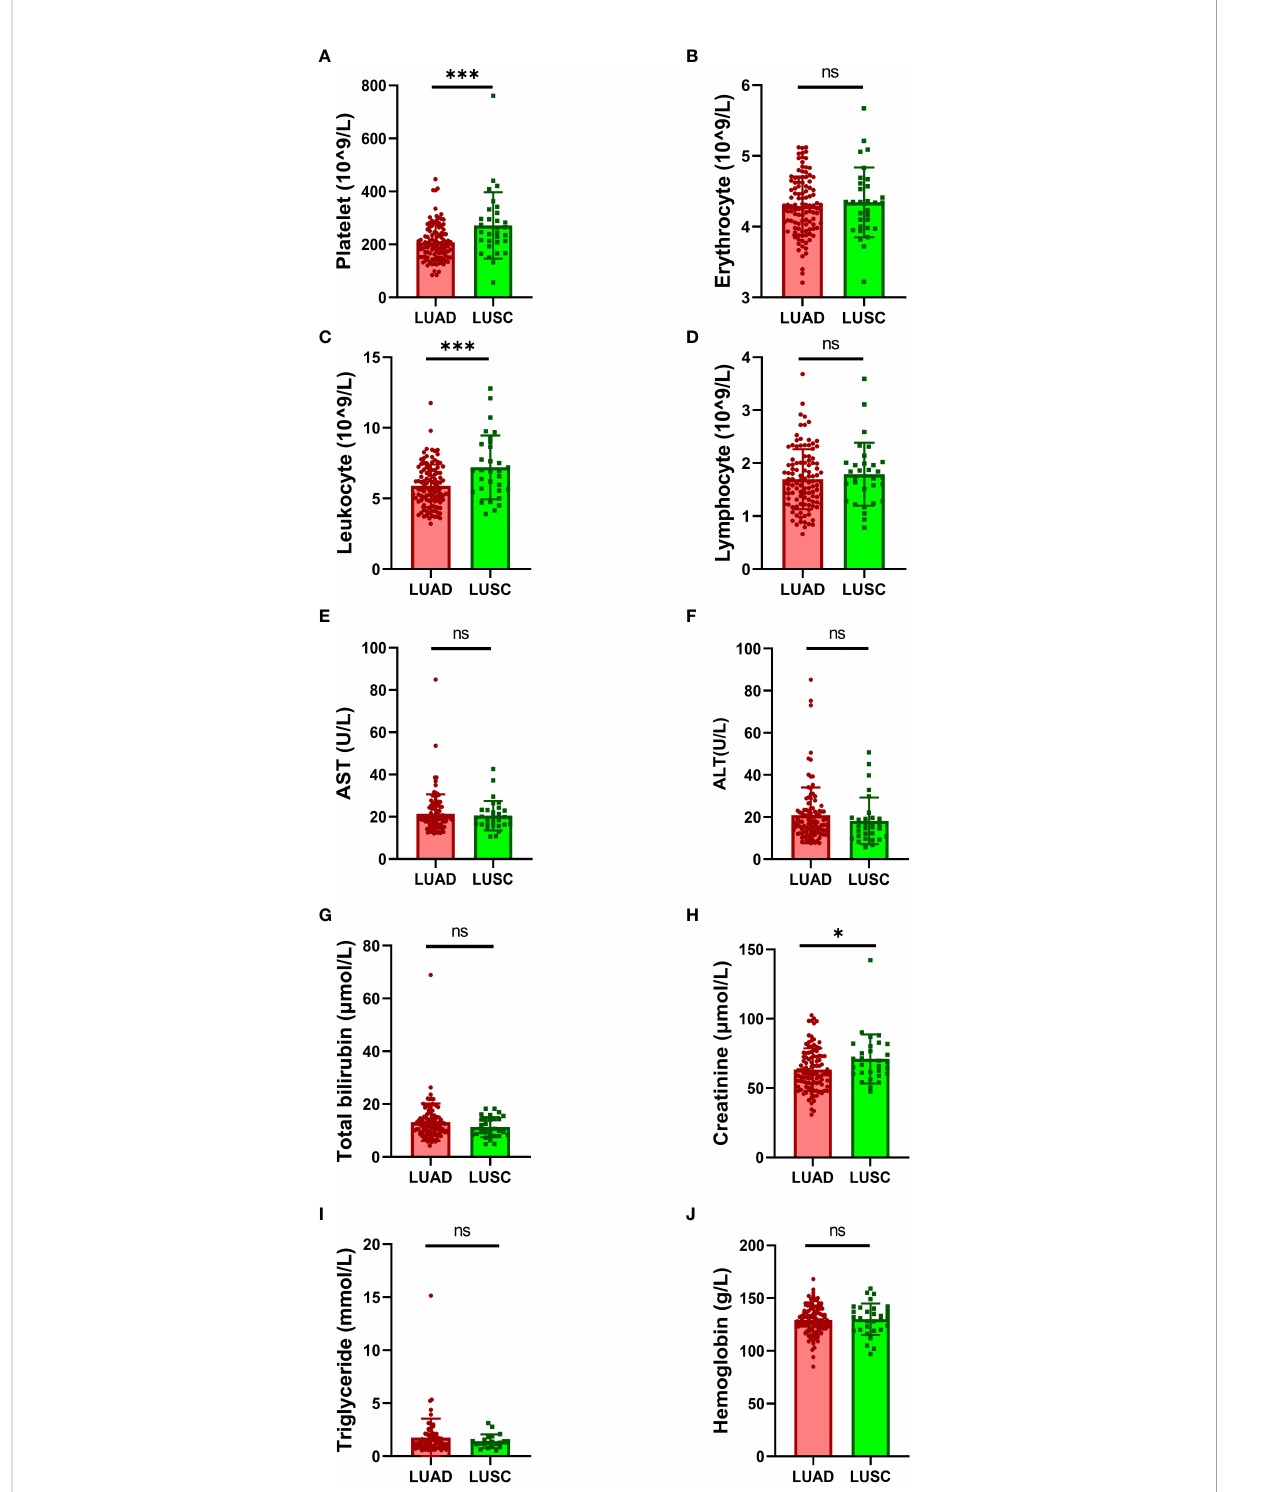
FIGURE 1 Comparison of laboratory data between LUAD and LUSC. Comparison of the number of blood cells: (A) platelets, (B) erythrocytes, (C) leukocytes and (D) lymphocytes. Comparison of the level of physiological indexes: (E) AST, (F) ALT, (G) total bilirubin, (H) creatinine, (I) triglyceride and (J) hemoglobin. AST, aspartate transaminase; ALT, alanine aminotransferase. Data were analyzed by the 2-tailed Student ’ s t test. * P < 0.05, *** P < 0.001; ns, not signi fi cant (p -value >